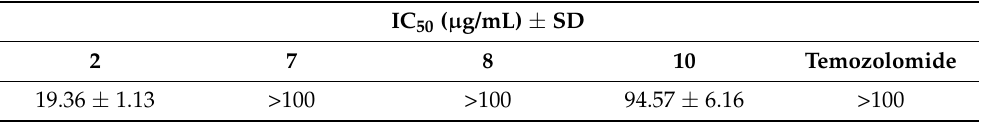
Table 4. Cytotoxic effect of TZD hybrids 2 , 7 , 8 , and 10 against human glioblastoma T98G